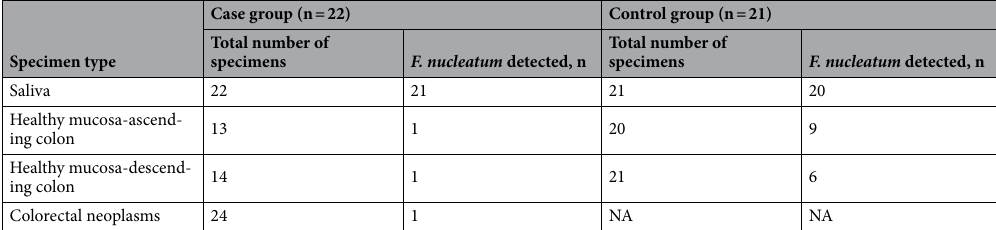
Table 4. Detection frequency of Fusobacterium nucleatum by specimen type and participant group. F. nucleatum Fusobacterium nucleatum , NA